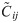
Spectral decomposition and ICA.A-B, The eigenspectrum of C˜ij (in black bars) for the G protein (A) and S1A (B) protein families. The eigenvalue distribution expected randomly is shown in red and provides a statistical basis for defining the k* top eigenmodes for further analysis—conservatively, those greater than the second random eigenvalue. The first random eigenvalue is ignored since it is a trivial consequence of retaining the independent conservation of sites in the randomization process [10]. This analysis suggests k* = 4 and k* = 7 for the G and S1A families, respectively. C-D, The top three eigenvectors for the G (C) and S1A (D) families suggest the possibility of distinct groups of coevolving positions, but illustrates the property that these groups emerge along combinations of eigenmodes. E-F, Independent components analysis (ICA) optimizes the independence of groups emerging along the different directions, putting the top three groups of amino acids on nearly orthogonal axes. The group of positions contributing to each IC groups is defined by fitting an empirical statistical distribution to the ICs and choosing positions above a defined cutoff (default, > 95% of the CDF). Groups of positions in panels C-F are defined and colored accordingly.